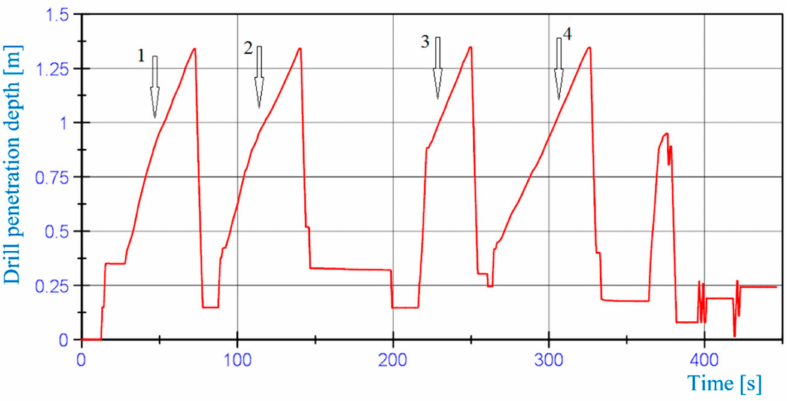
Figure 8. Recorded progression of displacements measured with a cord encoder for borehole No. 6.